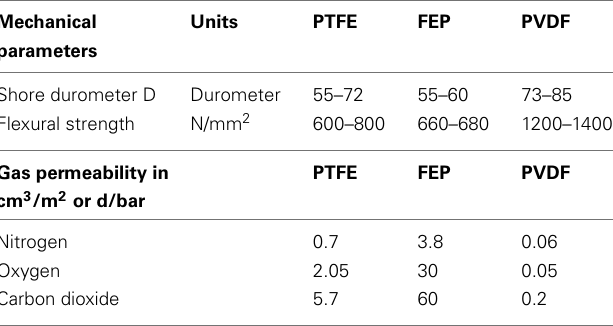
Table 1 | Comparison of mechanical parameters and gas permeability of PTFE, FEP, and